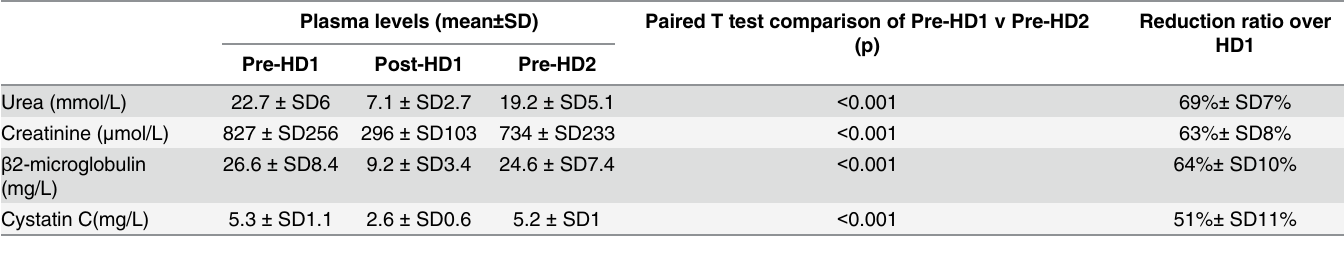
Table 3. Plasma levels of molecules at each study time-point Plasma levels (mean ± SD) Paired T test comparison of Pre-HD1 v Pre-HD2